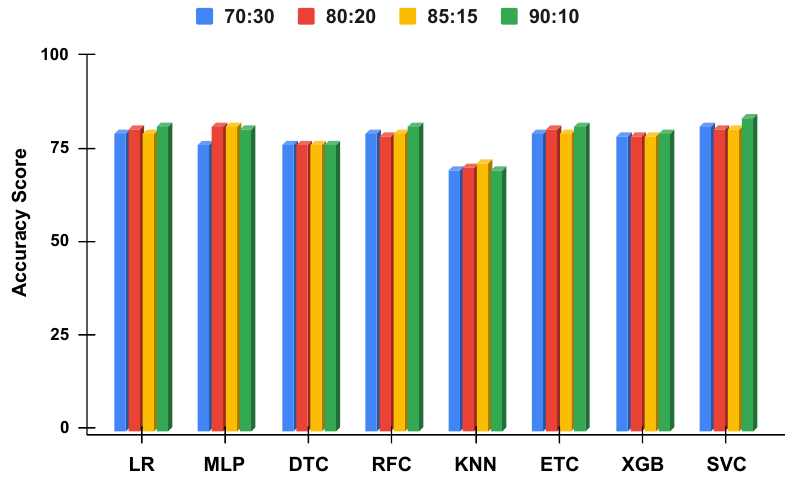
Figure 12. The applied techniques performance comparative analysis of different data split ratios with proposed technique using balanced data.